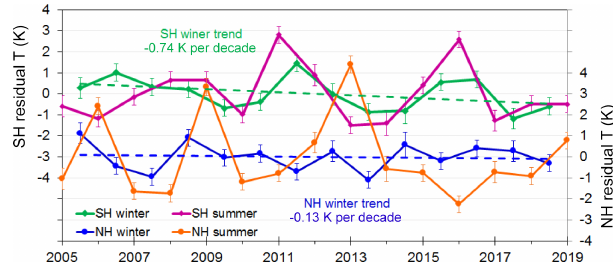
Figure 10. Time series of Aura/MLS temperature residuals at the 0.0046hPa pressure level averaged over the SH polar cap (65– 85 ◦ S) for winter months (AMJJAS; light green line) and summer months (ONDJFM; purple line) and the NH polar cap (65–85 ◦ N) for summer months (AMJJAS; orange line) and winter months (ONDJFM; blue line). Scales offset by 3K for